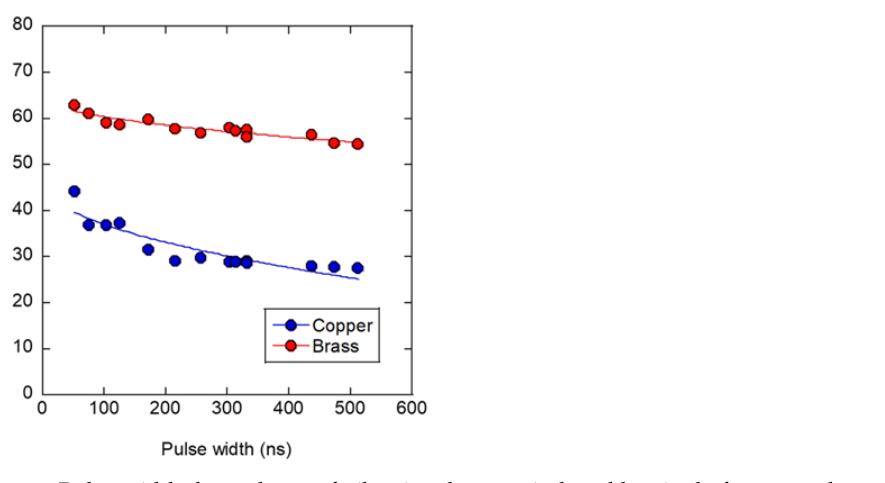
Figure 6. Pulse-width dependence of vibrational power induced by single-frequency low-energy laser excitation.